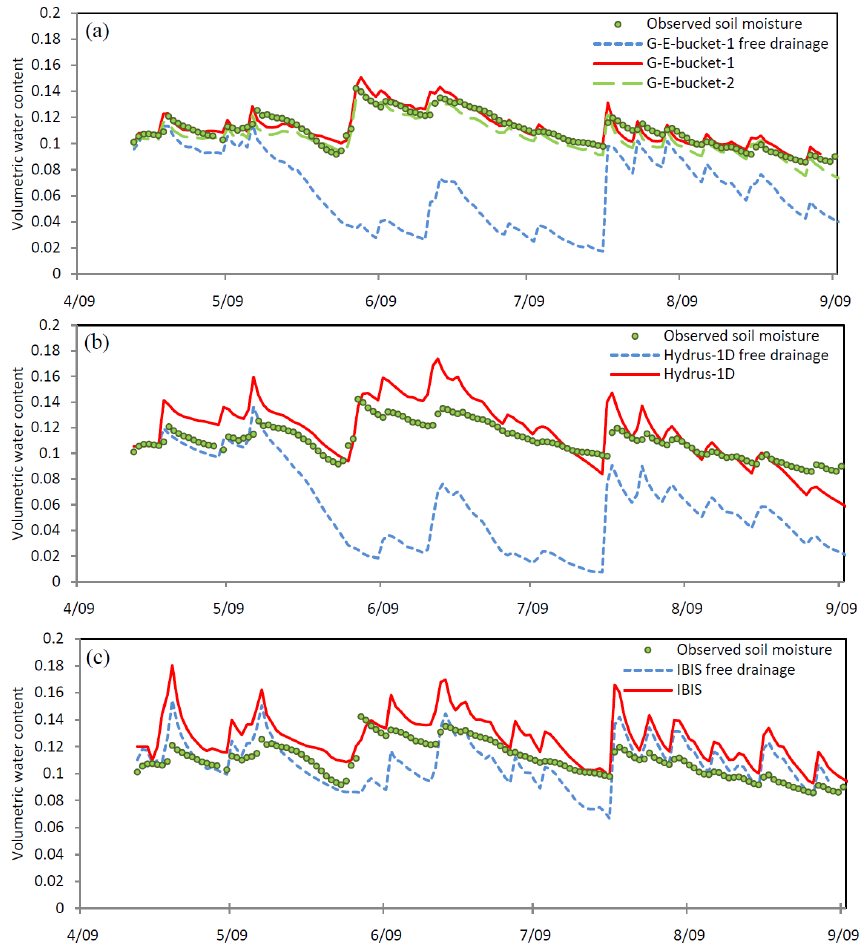
Fig. 3. Observed and simulated depth-averaged soil moisture (i.e., volumetric water content down to 50 cm) for the (a) two G-E bucket models, (b) Hydrus-1D model, and (c) IBIS model during the 2009 model evaluation period (see Table 3). Simulation results using free drainage as the lower boundary condition are represented by blue dashed lines. Green dots show the daily mean soil moisture observations from the field site.